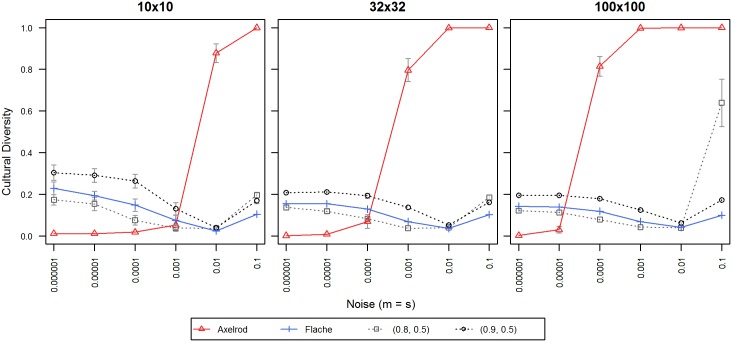
Cultural diversity for different models (Axelrod's, Flache's, and ours).X-axis displays levels of noise; Y-axis displays normalized cultural diversity. Each colored line symbol denotes one of three models, i.e. Axelrod's (continuous red), Flache's (continuous blue), ours with α = 0.9 and α' = 0.5 (dotted black) and ours with α = 0.8 and α' = 0.5 (dotted gray). 95% confidence intervals are displayed only when exceeding the size of the line symbol. Data points are averages of 50 repetitions per territory with 100,000 iterations per agent.